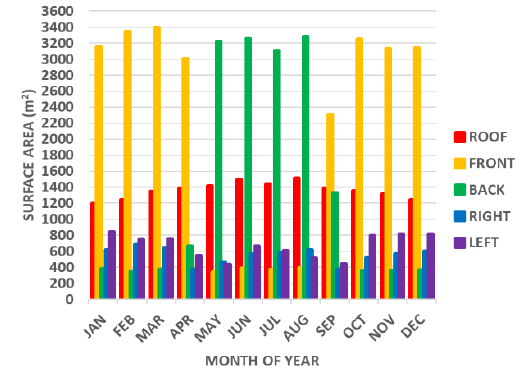
Figure 18. Monthly - Surface Receiving Radiation (2017) It shows that solar irradiation value trends for the roof, left and Figure 16. Screenshots of Gridded Solar Radiation Model right faces of the building are almost constant while trends for Visualized in Blender (January 01, 2017) the front and back faces show large deviations in certain times of the day. With additional yearly observations this can be used to From 8:00 to 16:00 the front face of the city hall has the largest predict the position of the sun relative to the city surface area that receives solar radiation. At 12:00, on average, the roof is the face of the building that receives the most solar radiation. Which means the front face of the building contributes the most solar irradiance than the rest of the faces of the building.